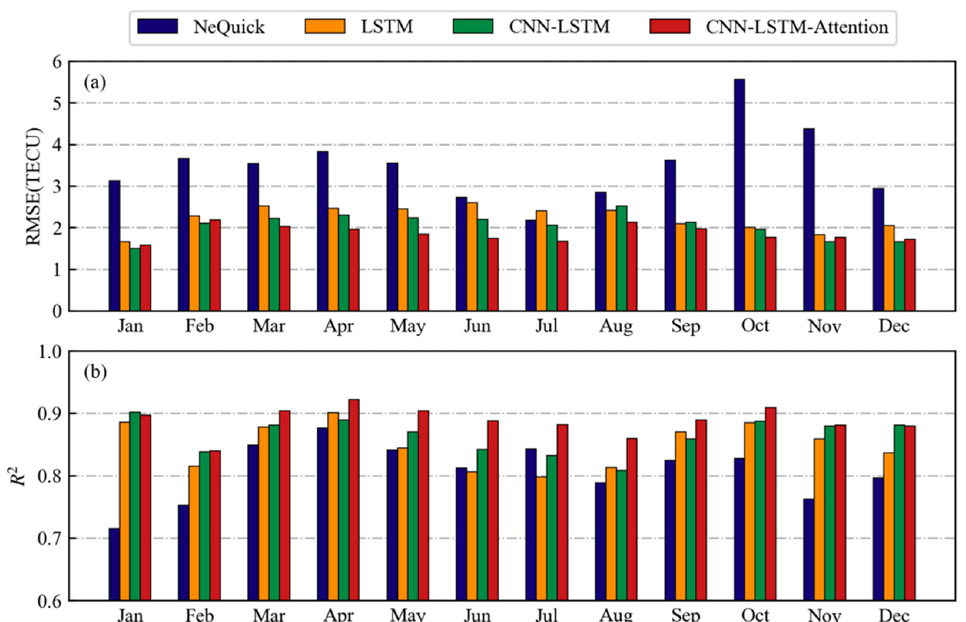
Figure 8. The RMSE and R 2 of NeQuick (blue bars), LSTM (yellow bars), CNN-LSTM (green bars), and CNN-LSTM-Attention (red bars) models from 12 months in the test set. ( a , b ) are RMSE and R 2 , respectively.